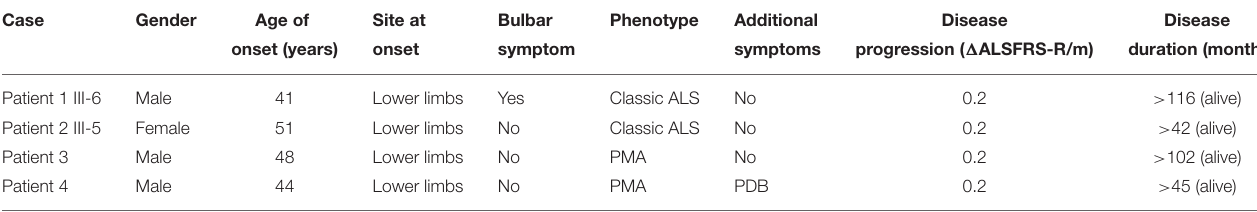
TABLE 1 | Clinical features of the amyotrophic lateral sclerosis (ALS) patients with valosin-containing protein (VCP) p.R155C mutation in this study.